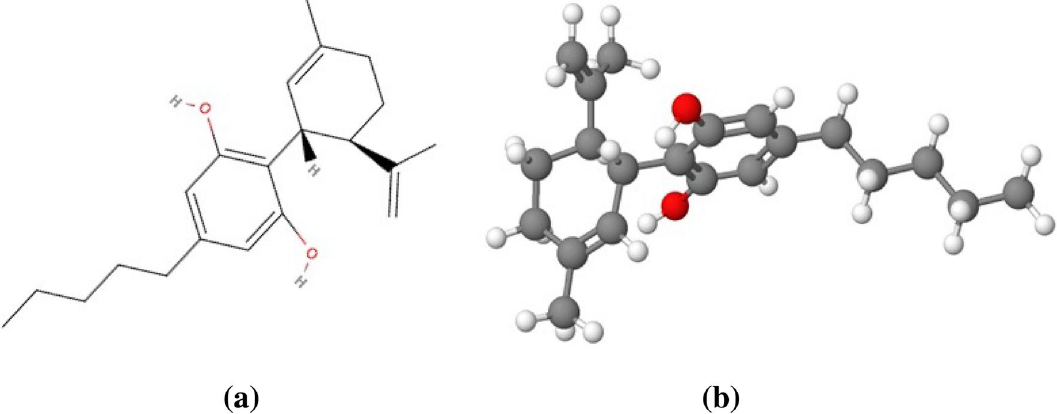
Fig. 2 Structural representation of cannabidiol a structural arrangement b 3D- model of the